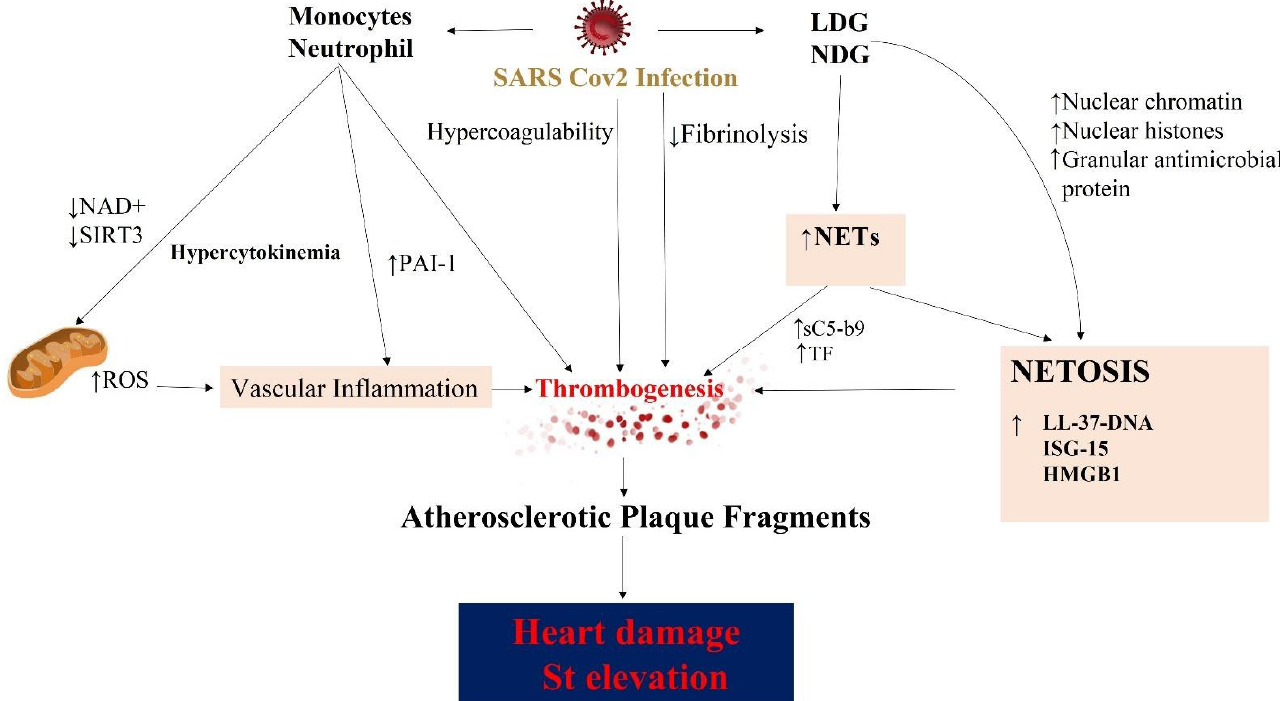
Figure 6. Summary of the mechanism that induces heart damage from NET formation in patients with severe COVID-19. Three distinct processes result in heart damage: vascular inflammation, thrombogenesis, and NETosis. Abbreviations: HMGB1, high-mobility group box 1; ISG-15; interferon-stimulated gene; LDG, low-density granulocyte; LL37, active cathelicidin; NDG, normal density granulocyte; NAD, nicotine adenine dinucleotide; ROS, reactive oxygen species; SIRT3, Sirtuin 3. Other abbreviations are as shown in previous figures. Arrows explain the increase or decrease of relative component